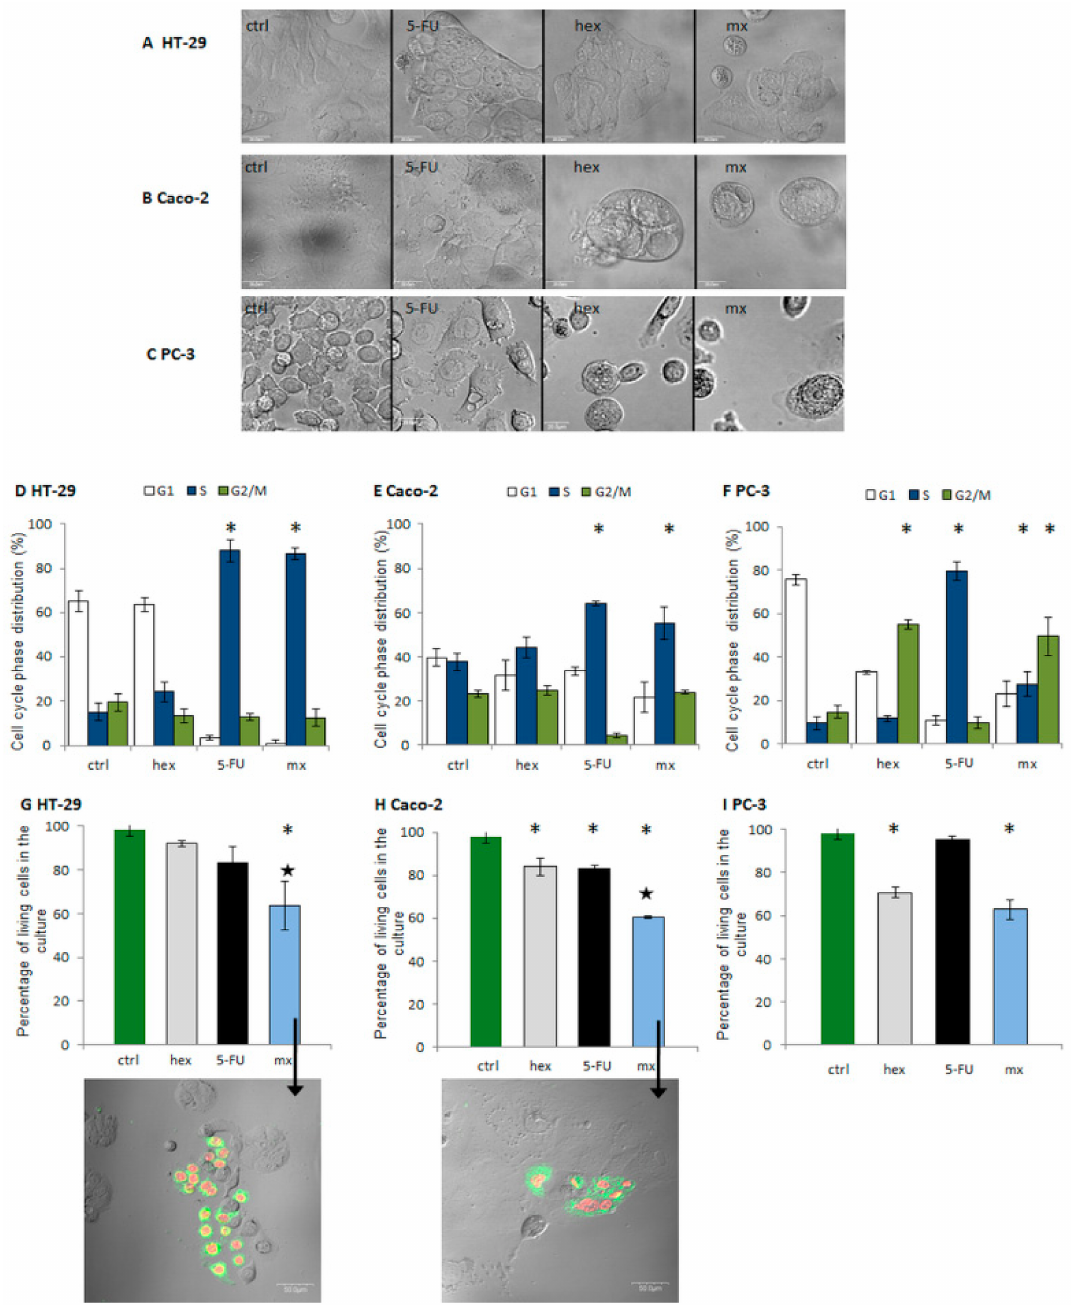
Figure 3. Morphological changes in the HT-29 ( A ), Caco-2 ( B ), and PC-3 ( C ) cells treated with 5-FU, hex, and the combined treatment (mx). The changes in distribution of the cell cycle phases in colon and prostate cancer cell lines when compared to the control after the administration of the combined treatment and the individual compounds in the HT-29 ( D ), Caco-2 ( E ), and PC-3 ( F ) cell lines. Cell cycle distribution was determined by flow cytometry. Combination treatment: the cells were incubated with 2-oxohexyl ITC for 24 h and then with 5-FU for 72 h. In individual administrations, one component of the combination was used. The changes of the living cells percentage in the cell culture after the administration of individual compounds and the combined treatment in the Caco-2 ( G ), HT-29 ( H ), and PC-3 ( I ) cell lines. Large black star—statistically significant difference between the percentage of living cells after the administration of the combined treatment and after administrations of 2-oxohexyl ITC and 5-FU alone. * Statistically significant difference from the control; p < 0.05. Cell viability was determined using the FDA/PI method using flow cytometry. Apoptosis detection in HT-29 colon cancer and Caco-2 cancer cell lines is indicated by arrows in graphs ( G , H ). Green—cell membrane stained with Annexin V-FITC. Red—nuclei stained with